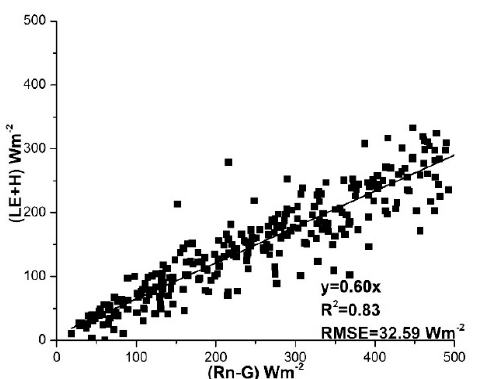
Figure 5. Linear regression between the components of the energy balance closure based on the EC flux measurements.